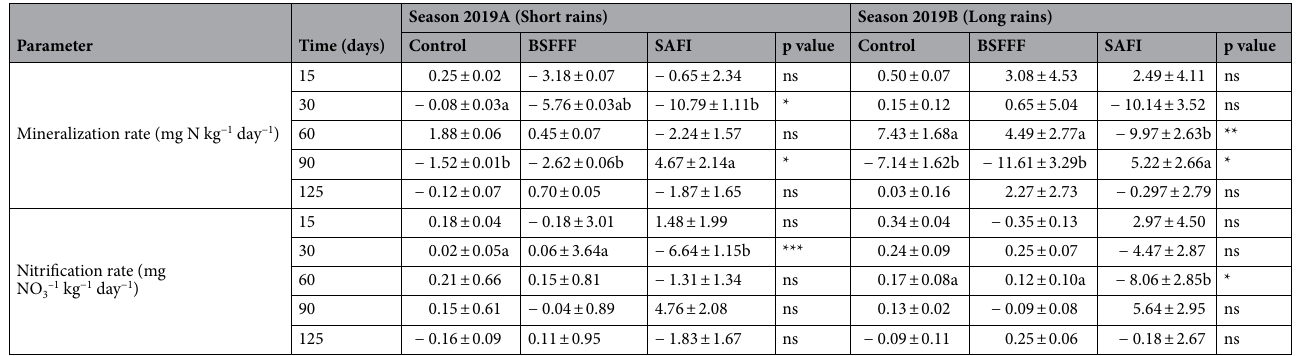
Table 2. Nitrogen mineralization and nitrification rates of soil amended with BSF frass and commercial organic fertilizers. ***p < 0.001, **p < 0.01, *p < 0.05, ns = not significant at p ≥ 0.05, BSFFF = Black soldier fly frass fertilizer, SAFI = commercial organic fertilizer, control = unamended soil. Within the same row and per parameter, means (± standard error) followed by the same letters are not significantly different at p ≥ 0.05, n =